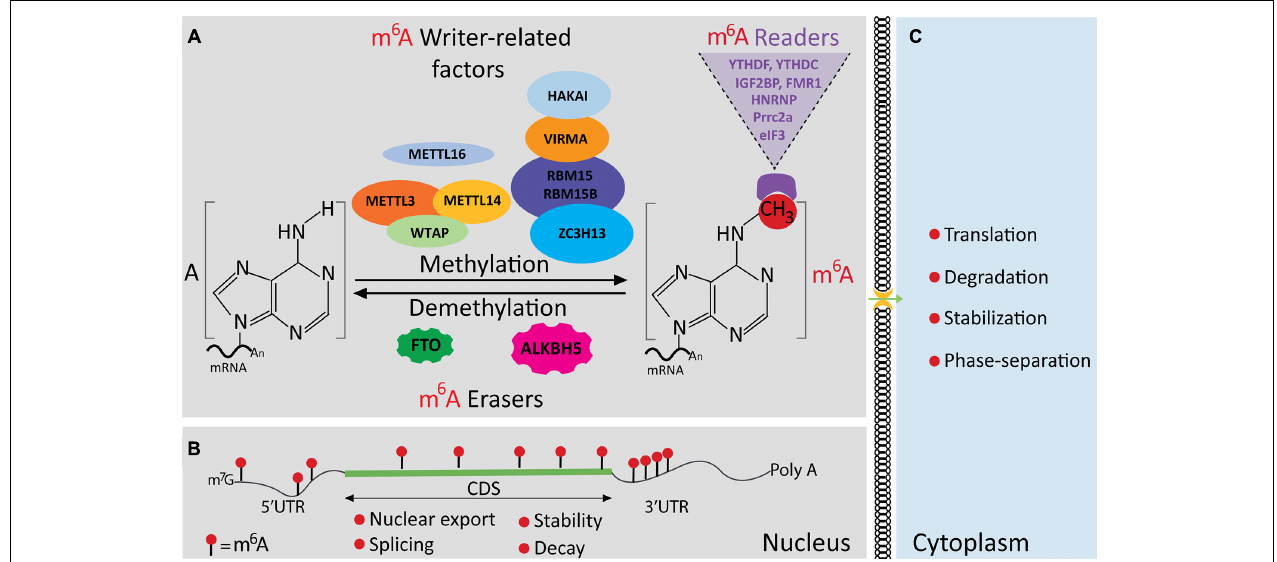
FIGURE 1 | The N 6 -methyladenosine (m 6 A) machinery and modification of messenger RNA (mRNA). (A) An illustration showing the m 6 A machinery. It is made of factors that can functionally be categorized as writers, erasers, and readers of m 6 A. The m 6 A marks are deposited by the methylation complex (writers), including METTL3, METTL14, and WTAP, which is counteracted by the m 6 A demethylases (FTO and ALKBH5), leading to m 6 A removal. The recognition of m 6 A marks is done by the readers or binding proteins as indicated. (B) Diagram showing a typical m 6 A distribution in regions of an mRNA located in the nucleus. (C) The m 6 A readout affects mRNA fates, including trafficking, stability, decay, translation, and